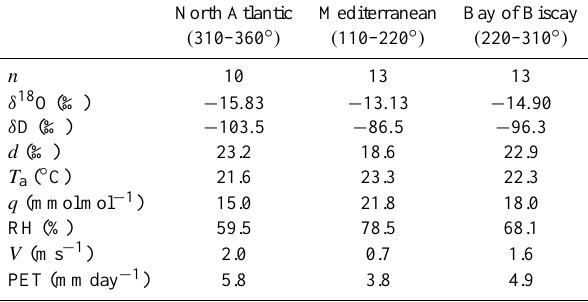
Table 5. Number of days ( n ) associated with the different origins of air masses (Fig. 1). Corresponding mean values of δ 18 O, δ D, deuterium excess ( d ), air temperature ( T a ), mixing ratio ( q ), rela- tive humidity (RH), wind speed ( V ) and potential evapotranspira- tion (PET) measured in the experimental